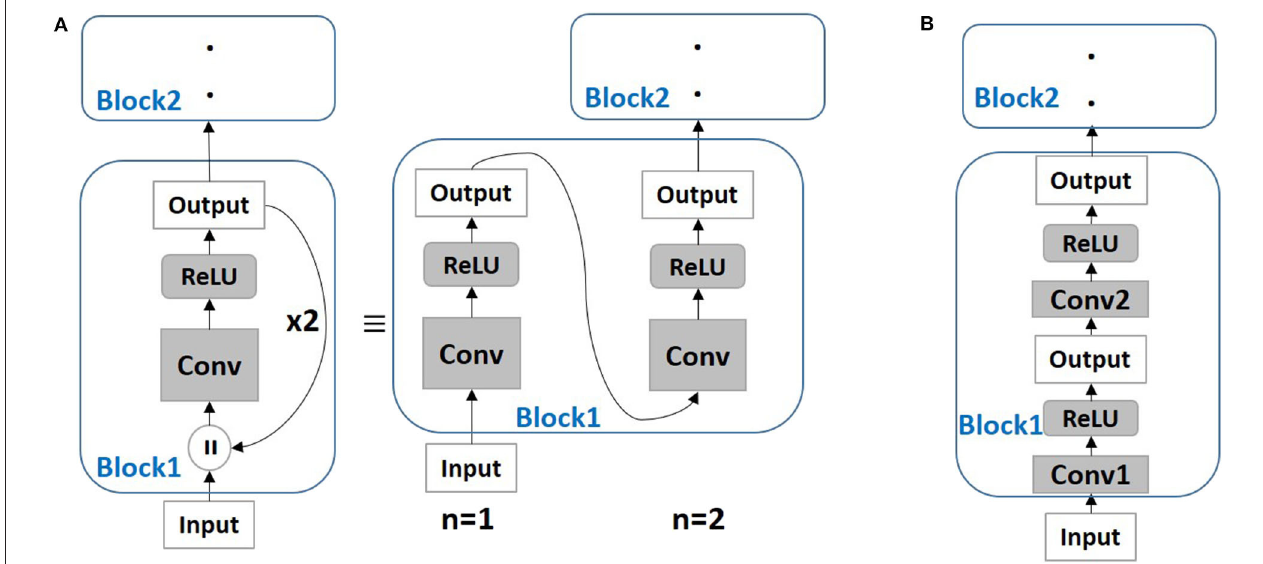
FIGURE 1 | (A) A simple neural network architecture with Backward Residual (BackRes with n = 2) connections is shown. The layers in Block 1 are unrolled n = 2 times to perform the BackRes computation with weights of Conv layer reused at each unrolling step. (B) A network with 2 unique convolutional layers in Block 1 is shown. Note, BackRes computation in (A) achieves the same logical depth of the network in (B)